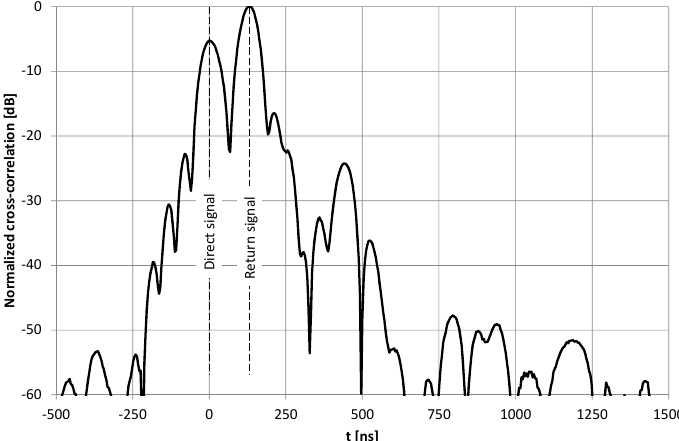
Figure 5. Example of cross-correlation function of signals recorded at d 1 = 39.3 m using two radiating cables with the amplifier.